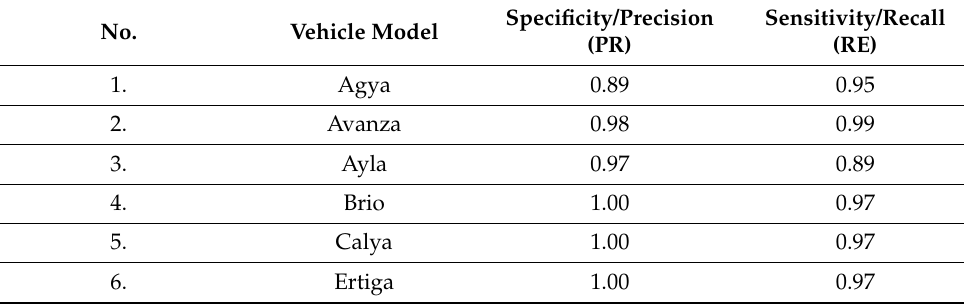
Table 7. Validity test result for vehicle model classification task from VGG-16